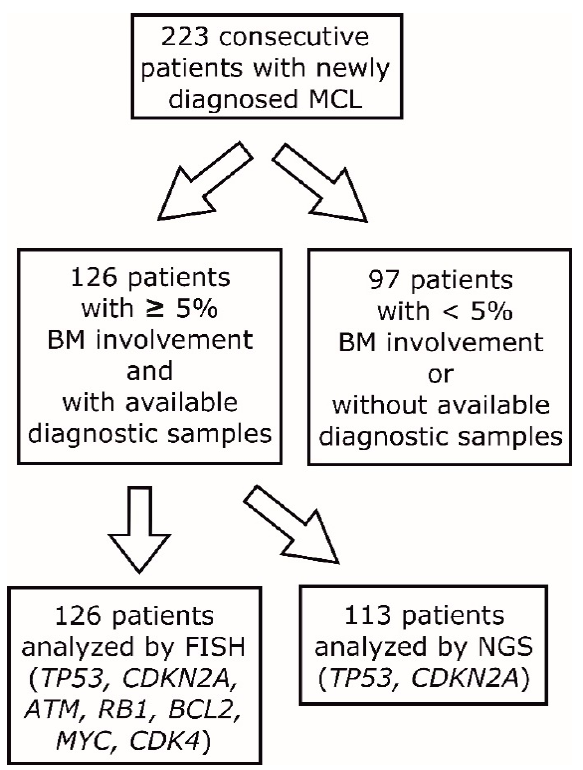
Figure 1. Flow chart of patient analysis. BM = bone marrow, FISH = fluorescent in-situ hybridization, NGS = next-generation sequencing.